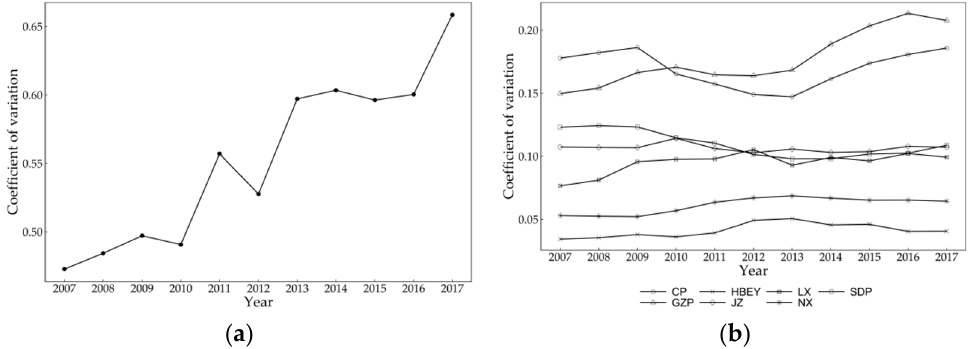
Figure 9. The evolutionary trend of σ convergence of CEI of urban agglomerations in the YRB from 2007 to 2017. ( a ) All cities. ( b ) Urban agglomerations.